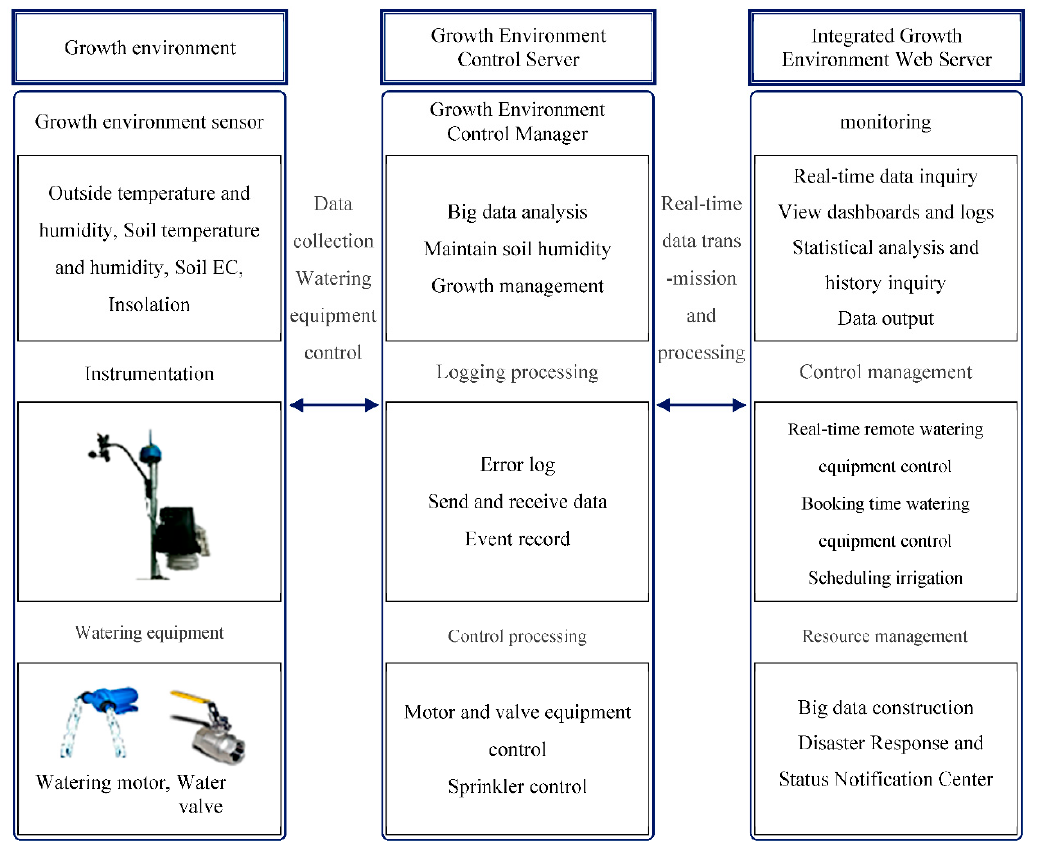
Figure 9. Flow chart for storage in a web server by TCP / IP communication.